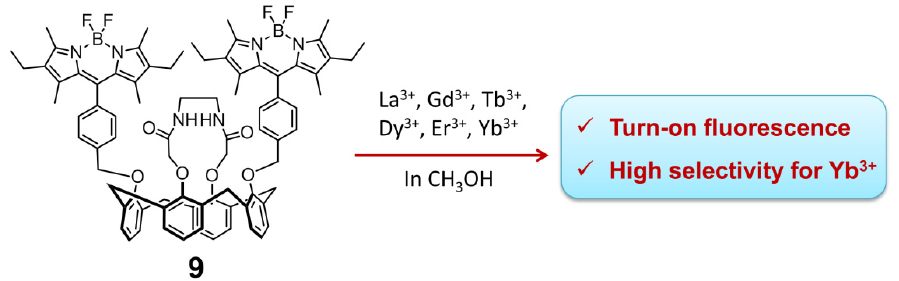
Figure 8. Chemical structure of calix[4]azacrown ether 9 appended with two BODIPY groups and two amide bridges.